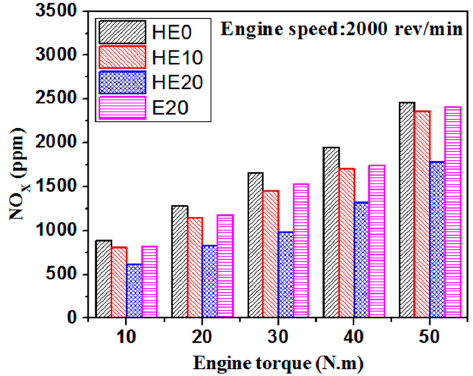
Figure 10. Difference of NO x emission with engine load.